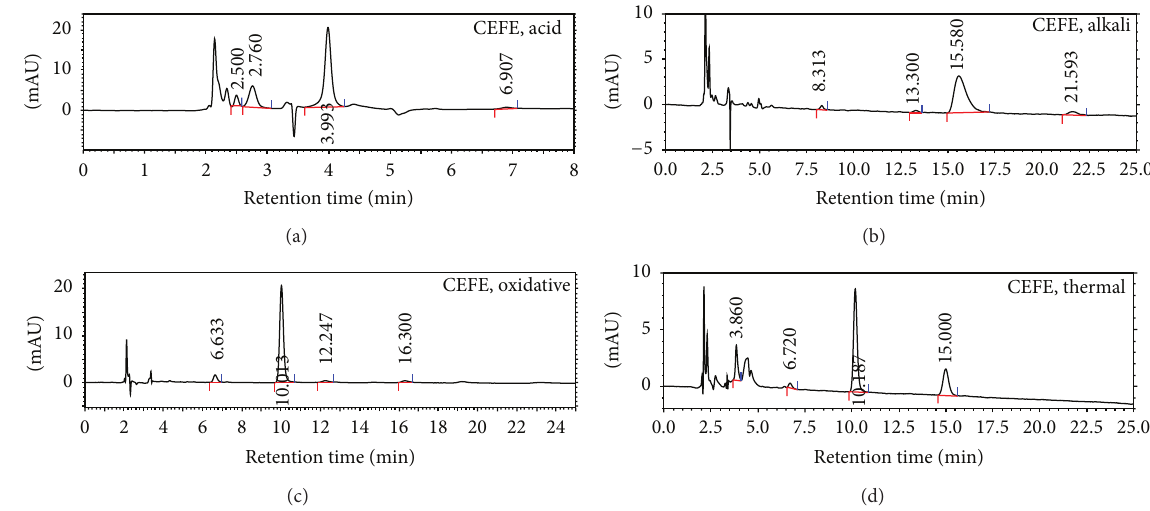
Figure 3: Chromatogram of specificity study of CEFE ((a) acid stress (b) alkali stress (c) oxidative stress and (d) thermal stress).